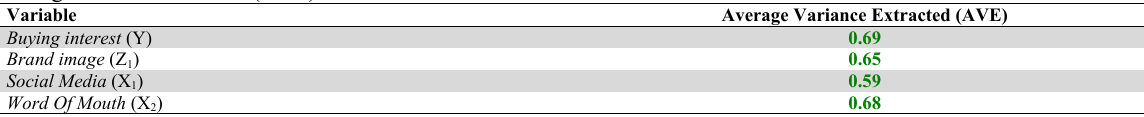
Average Variant Extracted